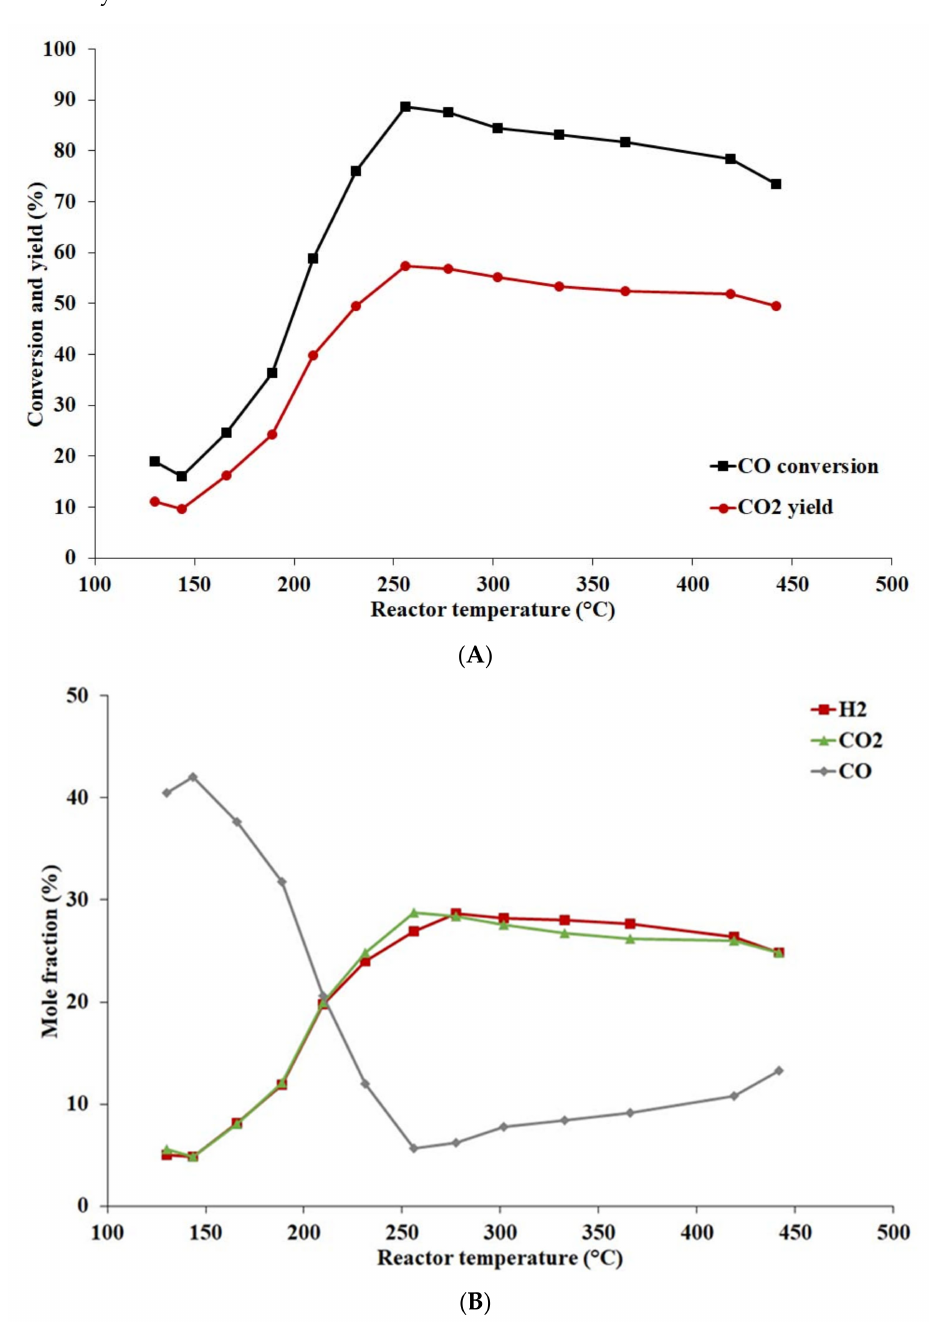
Figure 15. Catalytic tests on a Cu-based activated catalyst (8.1 wt%) prepared with calcined support with feed gas mixture 1 (50 mole% CO, 50 mole% N 2 ) at pressure 0.5 MPa: ( A )—CO conversion and CO 2 yield; ( B )—composition of the produced